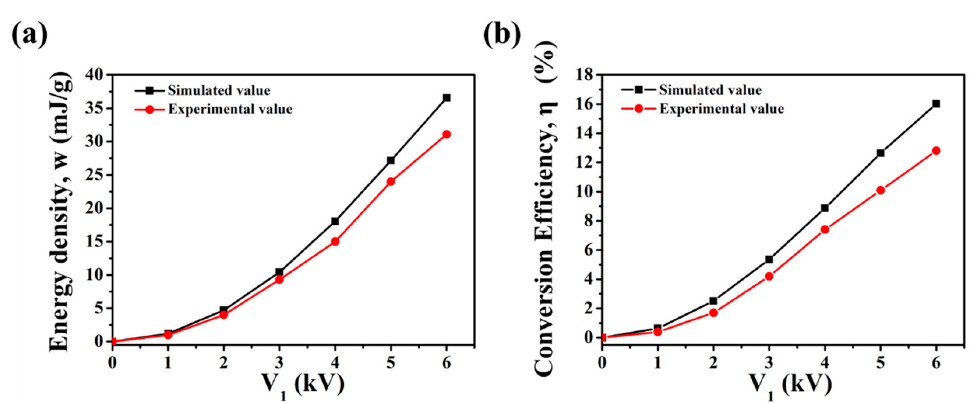
Figure 7. The experimental and simulated ( a ) energy density and ( b ) electromechanical conversion efficiency of the VHB4905 material under λ 1 = 2 and different V 1 values.